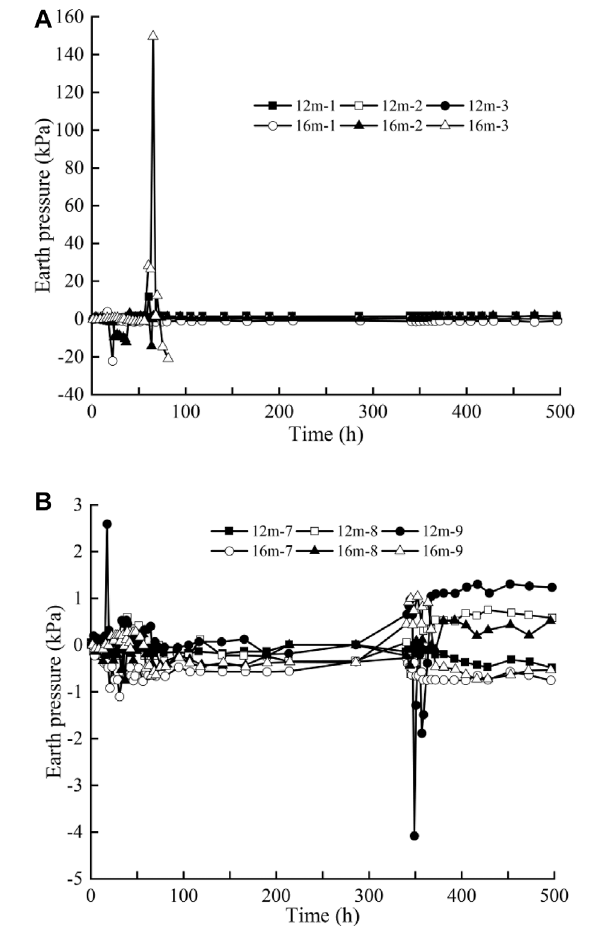
FIGURE 5 | Earth pressure on both sides of the tunnel with construction time: (A) left side and (B) right side.